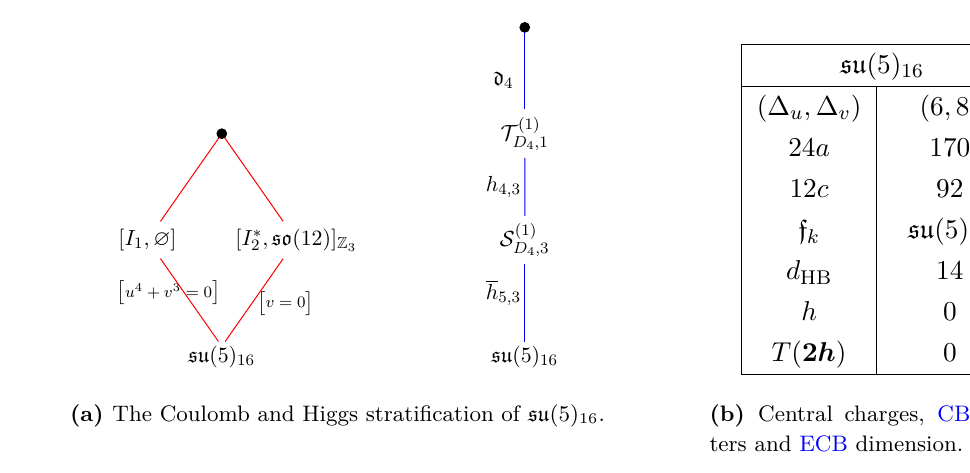
Figure 33. Information about the su (5) 16